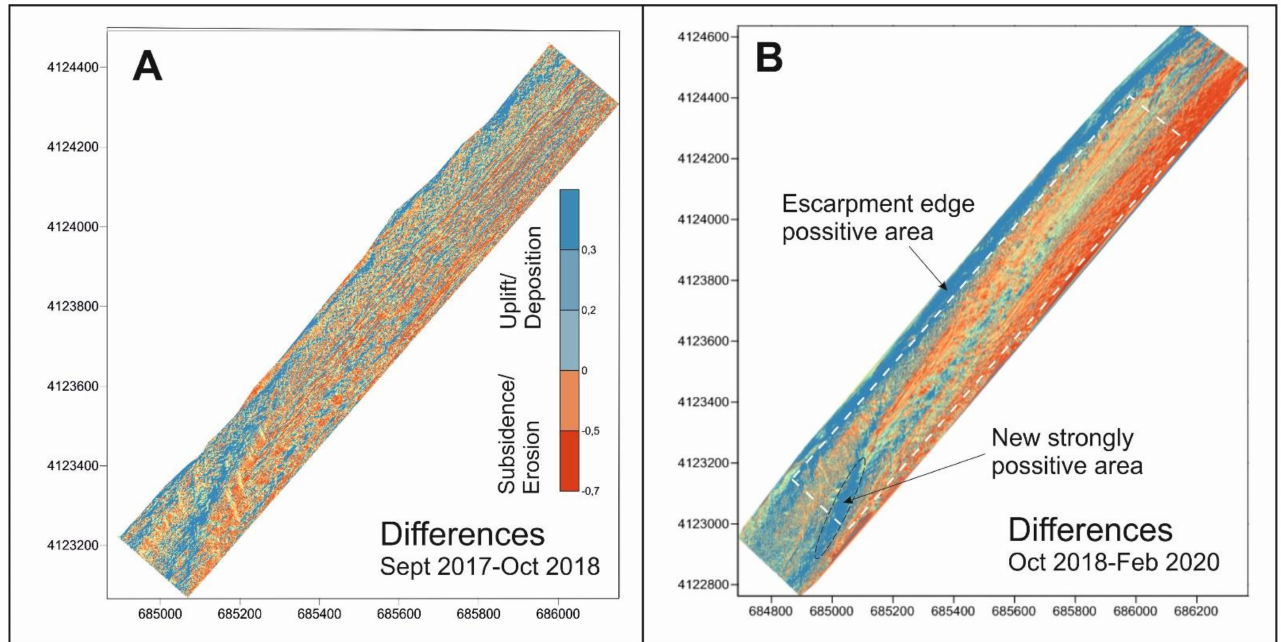
Figure 9. Maps showing the vertical differences between successive bathymetries (29S UTM coordinates in XY axis). ( A ) Differences between September 2017 and October 2018. ( B ) Differences between October 2018 and February 2020. Blue tones indicate areas where the later surface is higher than the previous one. Red tones indicate areas where the later surface is lower than the previous one. The dashed line in ( B ) shows the area of the surface represented in ( A